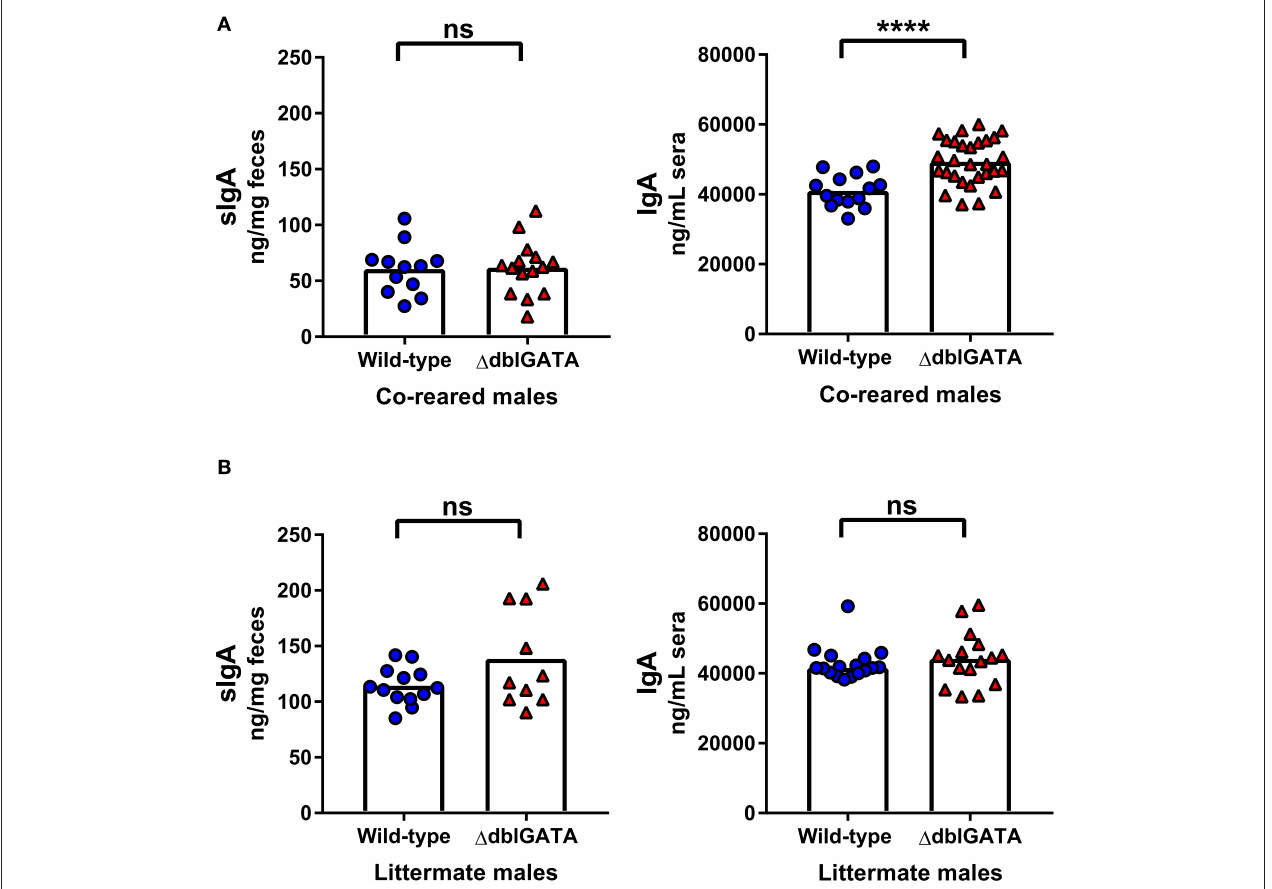
FIGURE 2 | No impairment in steady-state IgA levels in male 1 dblGATA mice that were co-reared or littermates with wild-type mice. Male wild-type and 1 dblGATA BALB/cJ mice were raised in the same cage from birth but born to dams of different genotypes (“co-reared”) or raised in the same cage from birth and born to heterozygous 1 dblGATA dams (“littermates”). Feces and serum were collected when offspring were over 6 weeks old, and fecal sIgA and serum IgA levels were quantified by ELISA. (A) Fecal sIgA data shown are pooled from three independent experiments, with a combined n = 12–15 in each group. Column heights are at the median value for each group and data were analyzed by a Mann-Whitney test. Serum IgA data shown are pooled from four independent experiments, with a combined n = 14–29 in each group. Column heights are at the mean value for each group and data were analyzed by an unpaired t -test. (B) Fecal sIgA data shown are pooled from three independent experiments, with a combined n = 10–13 in each group. Column heights are at the mean value for each group and data were analyzed by an unpaired t -test. Serum IgA data shown are pooled from three independent experiments, with a combined n = 16–17 in each group. Column heights are at the median value for each group and data were analyzed by a Mann-Whitney test. Each data point is representative of an individual mouse. ns, no statistical differences; **** = p ≤